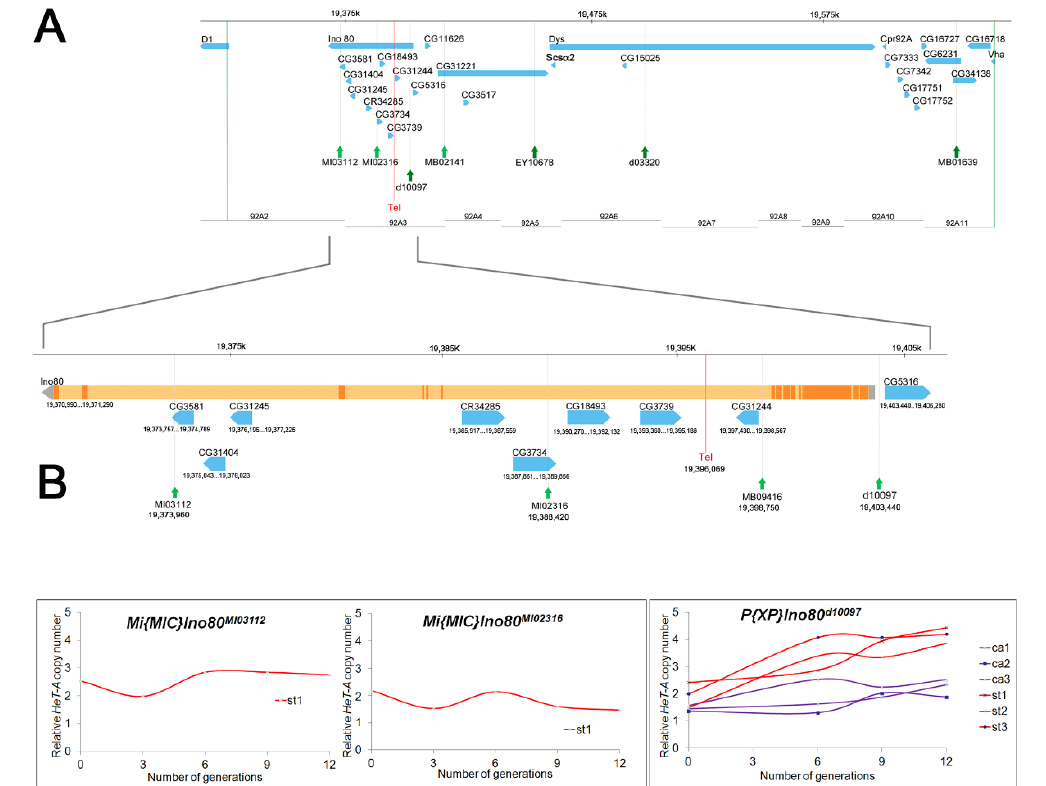
Figure 1. Localization of Tel 1 by site-specific recombination. ( A ) The upper chromosome map shows the candidate genes between two P element insertion sites, 05151 and 05113 (vertical green lines). This region was identified as containing Tel 1 based on Table 1, round 1. Positions of transposons used for further mapping are indicated by green arrows. The Tel 1 mutation is boxed in red. The lower chromosome map shows expansion of the 92A3 region. ( B ) Graphs showing the change in relative HeT-A copy number (telomere length) in recombinants of Tel 1 /MI02316 , Tel 1 /MI03112 , and Tel 1 /d10097 over 12 generations. The st recombinants are shown as red lines; ca recombinants as purple lines. These data delimit Tel 1 to a 15 kb between inserts MI02316 and d10097 (shown as red rectangles in ( A